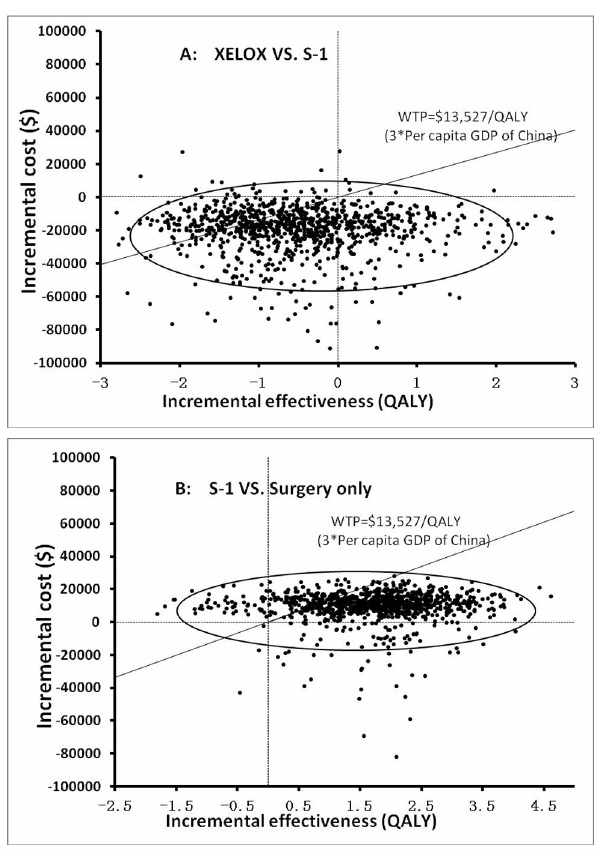
Figure 5. The results of Monte Carlo probabilistic sensitivity analysis for the strategies of capecitabine and oxaliplatin (XELOX) VS. S-1 (A) and S-1 VS. surgery only (B) are shown in two scatter plots. The solid lines indicate the $13,527 threshold. The estimates of 95% were surrounded in the